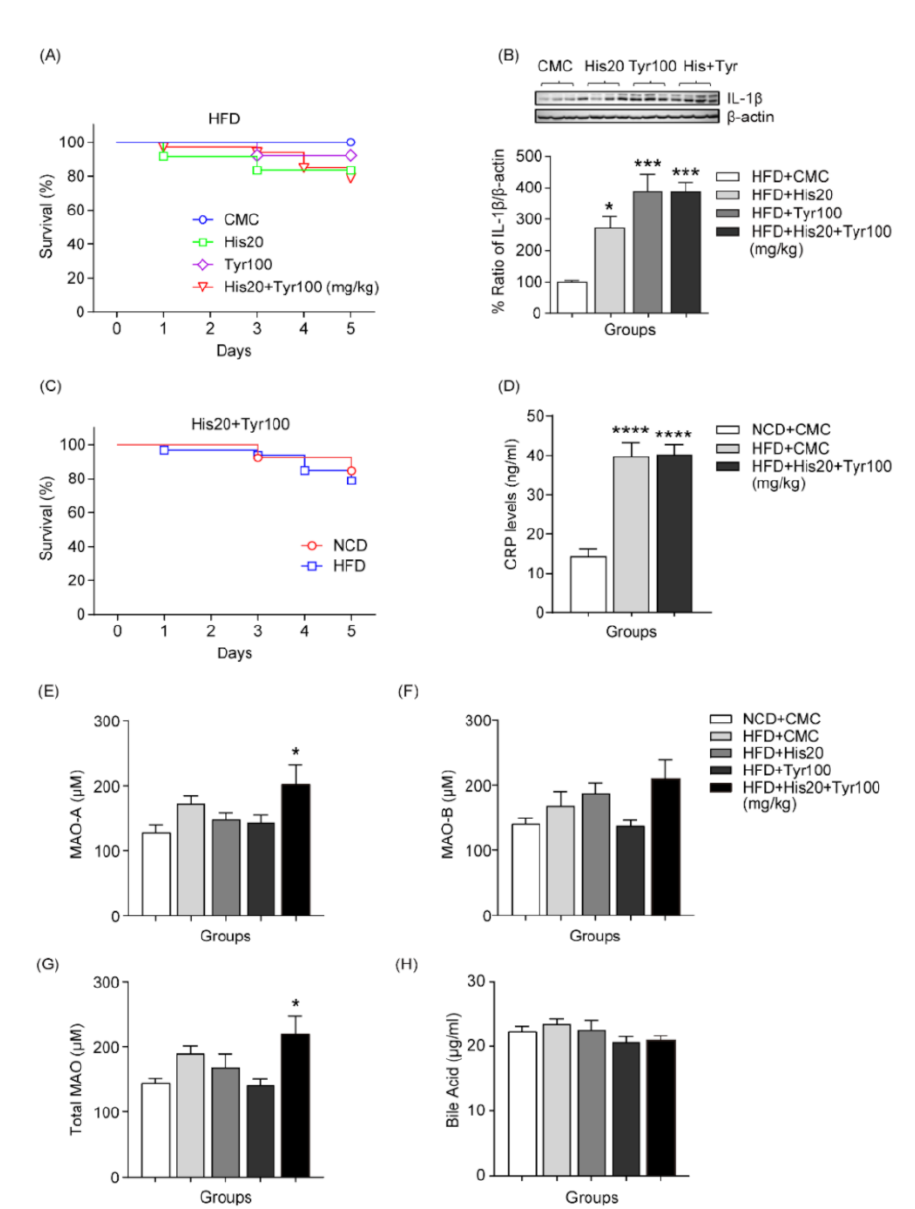
Figure 4. Effect of biogenic amines on liver damage in mice fed an HFD. ( A ) Changes in survival rate following single or repeated oral gavage administrations of biogenic amines after feeding an HFD. ( B ) Changes in IL-1 β following single or repeated oral gavage administrations of biogenic amines groups after repeated oral gavage administrations of biogenic amines. ( D ) Comparison of